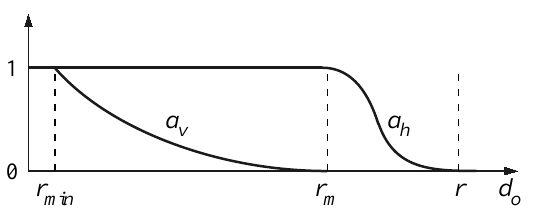
Figure 7. Weighting coefficients a v and a h as functions of the distance d o .